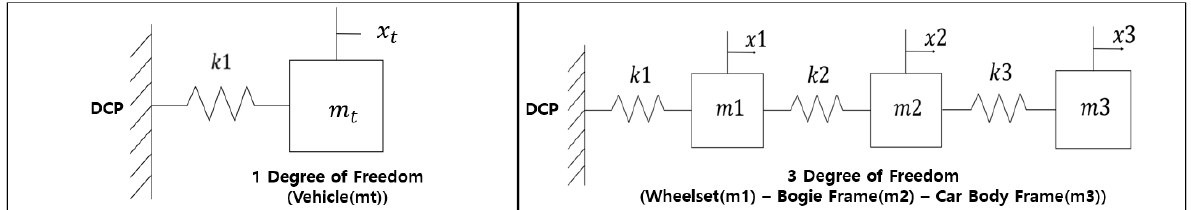
Figure 11. Simpli fi ed spring–mass model for a train vehicle. Figure 11. Simplified spring–mass model for a train